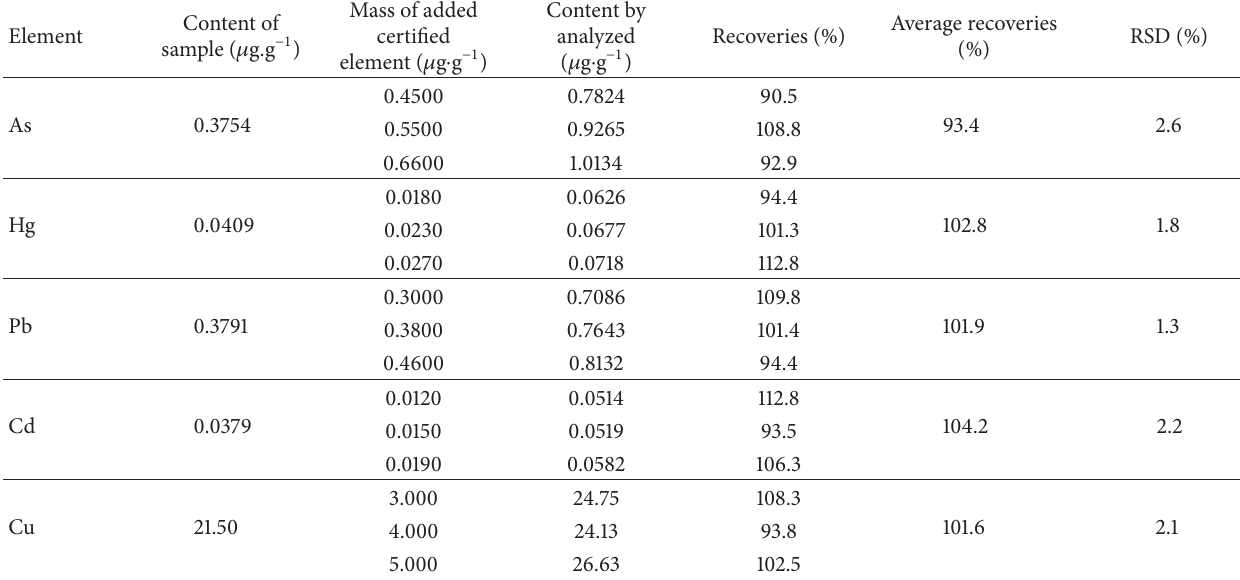
Table 5: The results of recovery tests (𝑛 = 9)